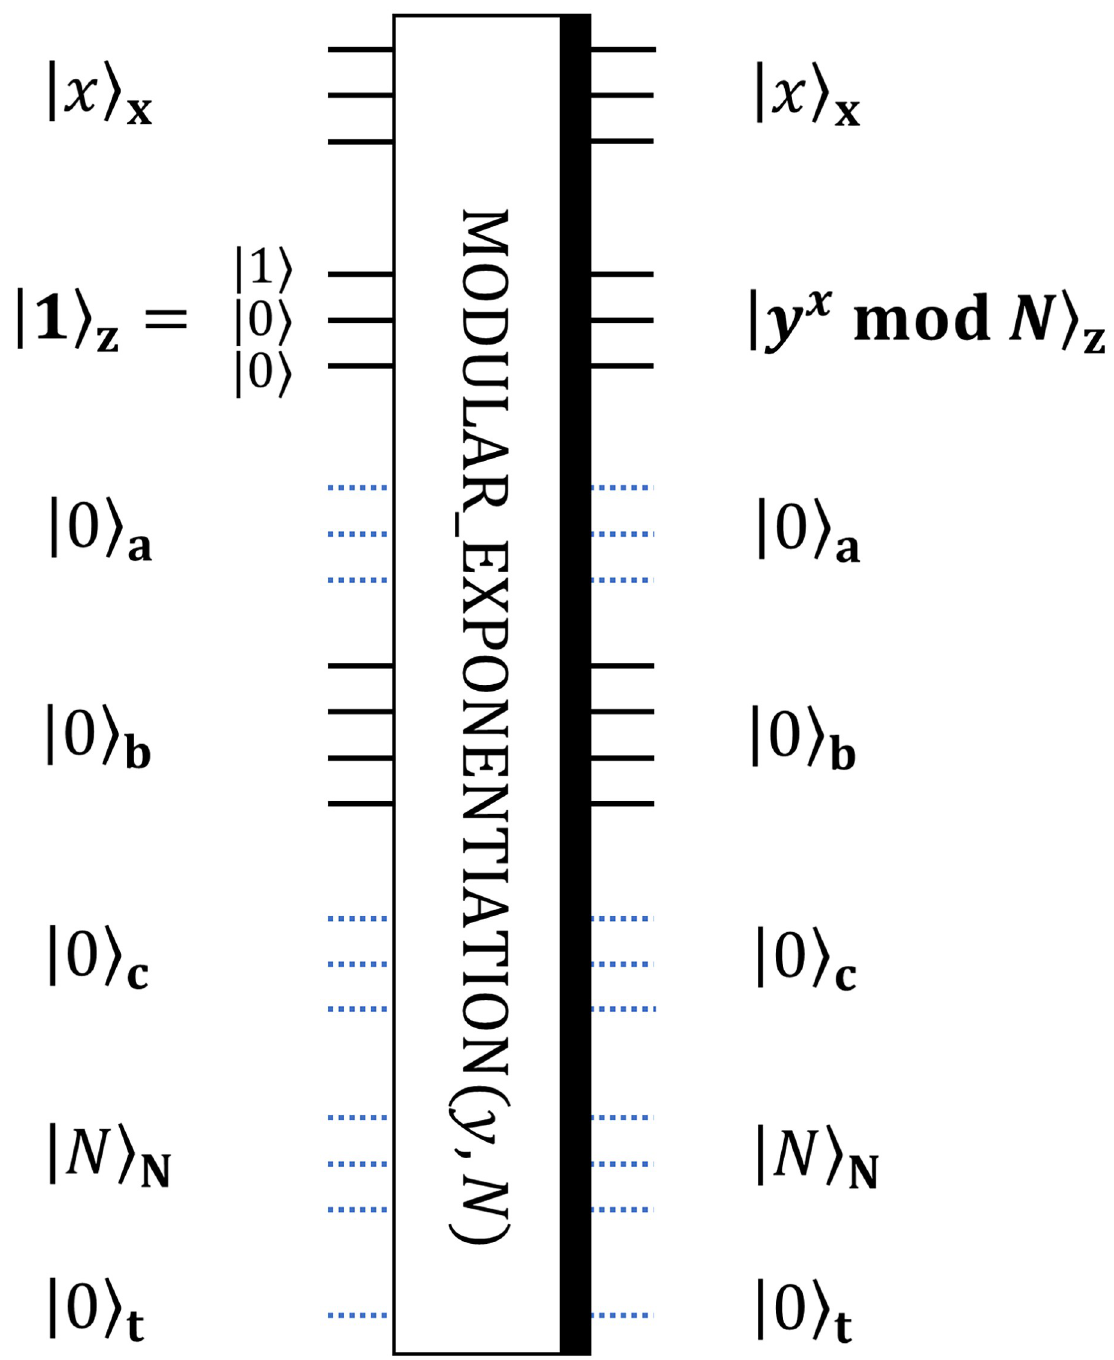
Fig 3. General notation for the circuit realizing modular exponentiation procedure. The procedure is for finding y x mod N given 3-bit integers x , y and N .